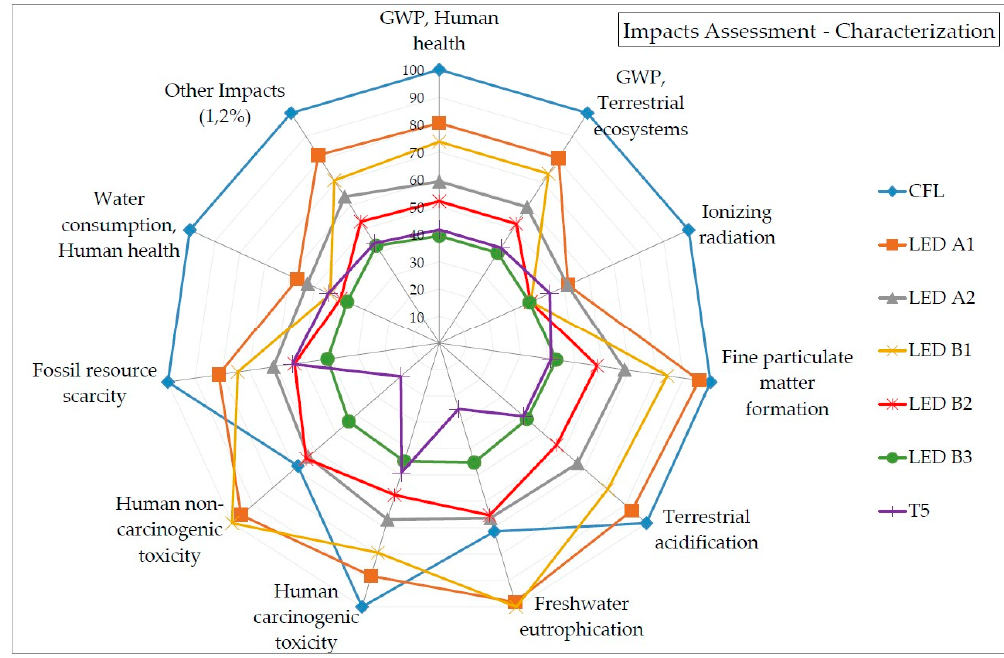
Figure 5. Midpoint potential impacts of lighting systems.